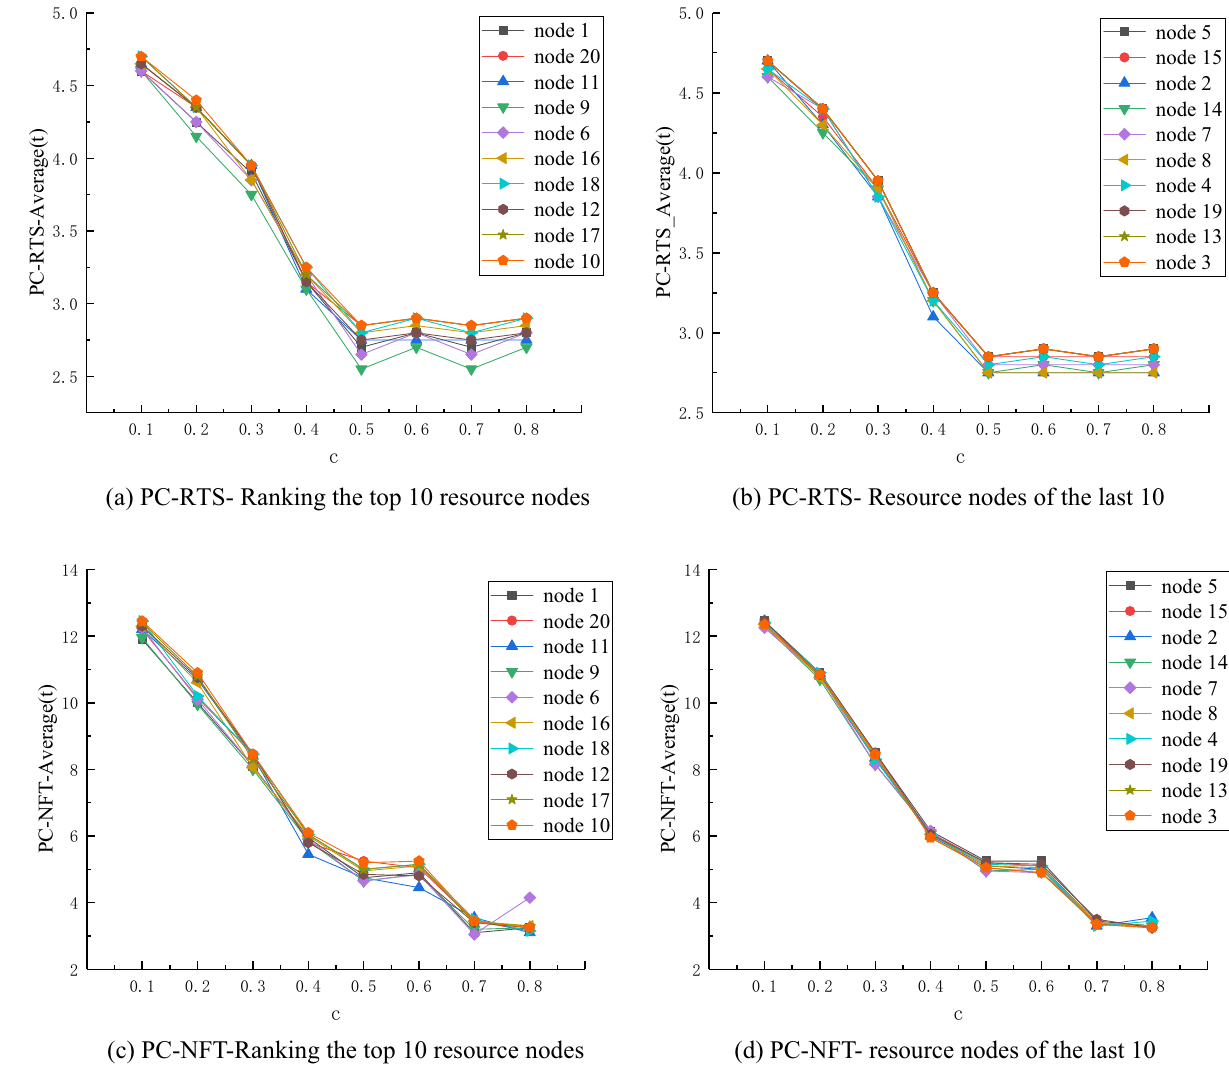
Figure 4. Network performance curve for R = 4 and c = 0.1, 0.2, 0.3, 0.4, 0.5, 0.6, 0.7,